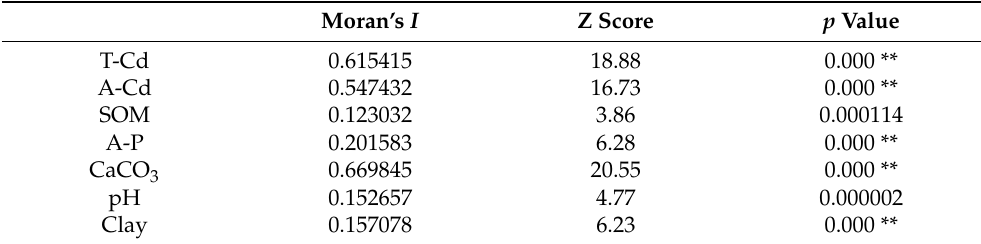
Table 4. Global autocorrelation degree of soil influencing factors.